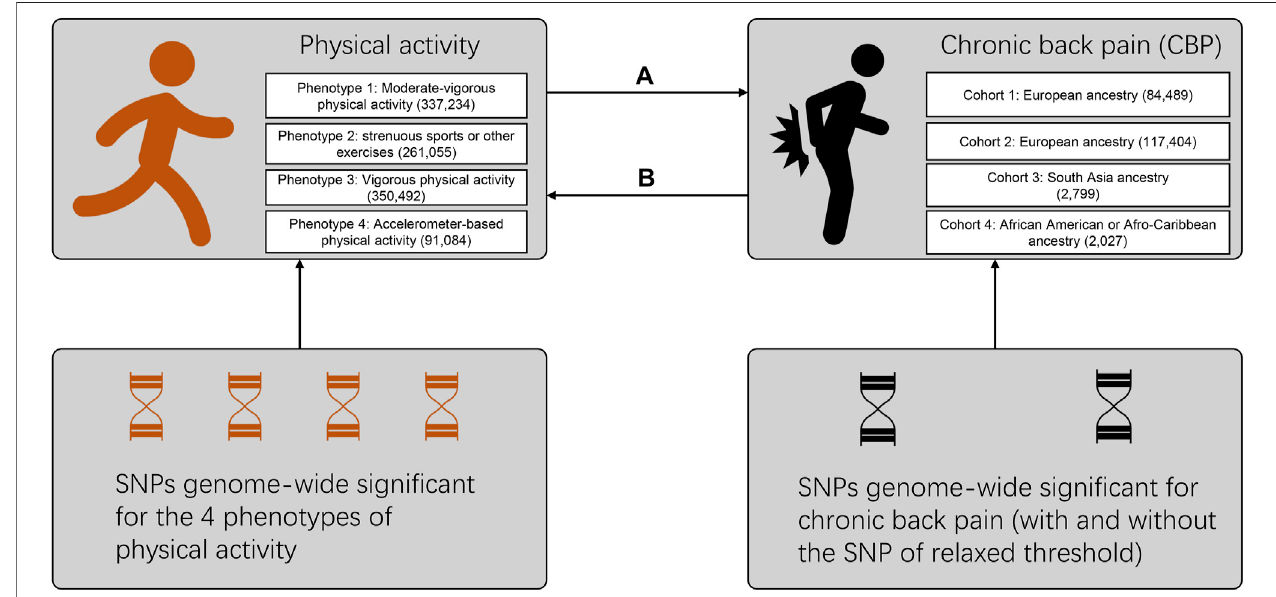
FIGURE1| Flowdiagramforthedesignofthebidirectional,two-sampleMendelianrandomizationstudy.Multiplephenotypesandcohortswerecross-validatedto maintain the robustness of our results. The direction marked (A) refers to the effect of physical activity on chronic back pain, while that marked (B) refers to the reverse effect.DetailsontheSNPsusedastraitinstrumentsaresummarizedin SupplementaryTablesS2 – S4 .Thenumbersofparticipantsfordifferentphenotypesorcohorts are labeled in the brackets. SNP: single-nucleotide